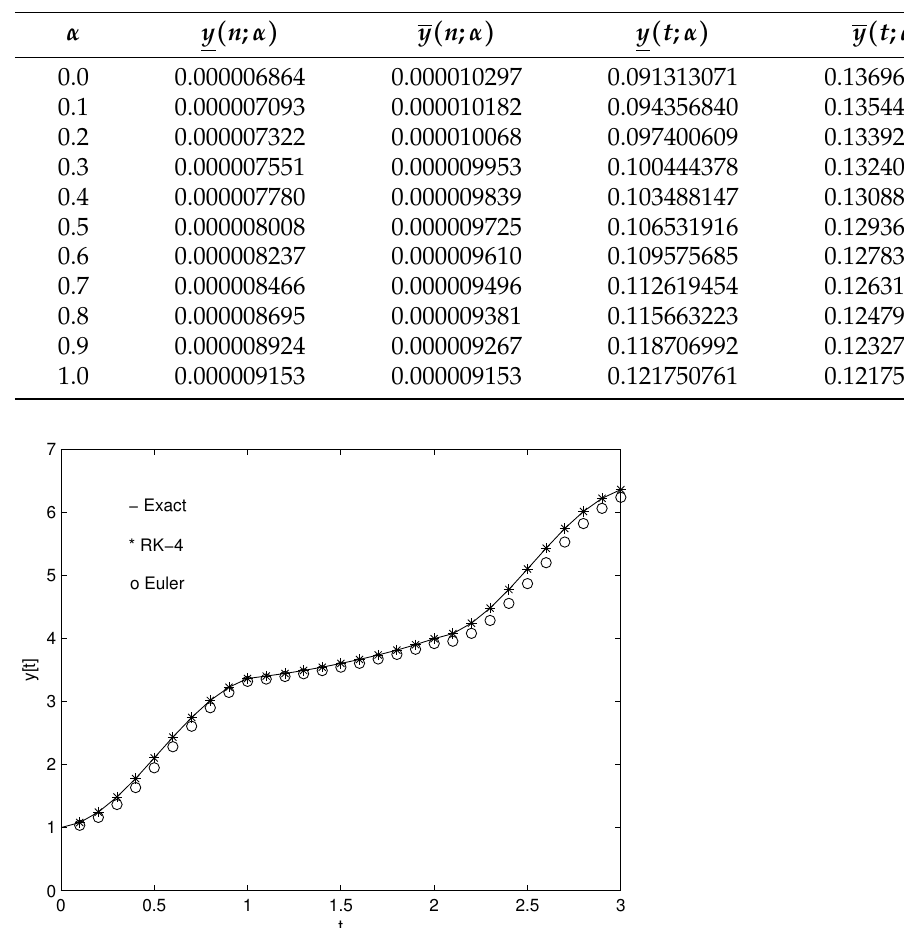
Figure 4. Graphical comparison of the approximate and exact solutions for h = 0.1, α = 1 and t ∈ [ 0,3 ]